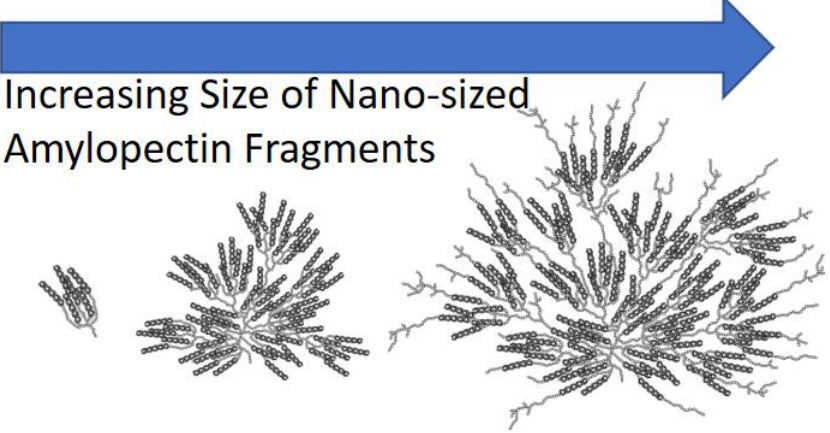
Figure 1. Depiction of the spatial arrangement of the clusters of helices for amylopectin samples of different sizes as predicted by the Solution-Cluster (Sol-CL) model [15].